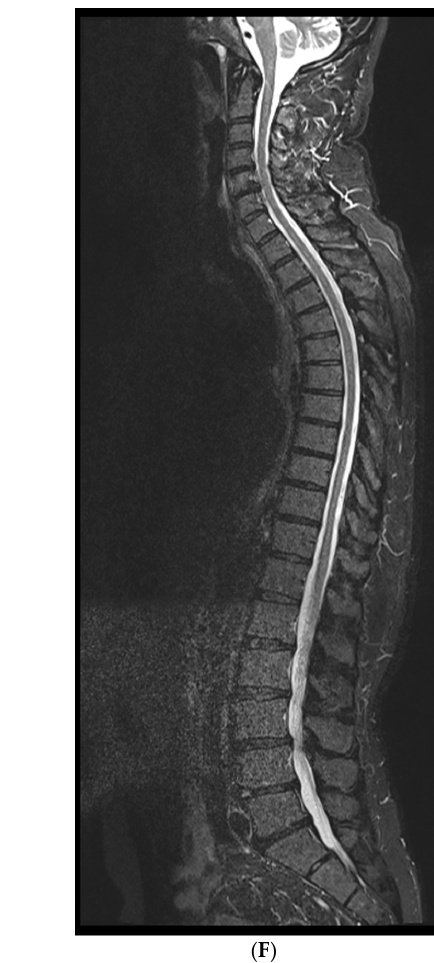
Figure 1. IgGk smoldering multiple myeloma (SMM) patient with negative whole-body computed tomography. Magnetic resonance imaging of the rachis and pelvis shows two focal bone lesions with increased signal intensity in T2-weighted STIR (short-tau inversion recovery) images. One small lesion (diameter: 5 mm) of the right iliac crest ( A ) and one bigger lesion (diameter: 14 mm) of the right acetabulum anterior column ( B ), with corresponding enhancement after Gadolinium injection in T1-weighted images with fat saturation ( C , D ). No further focal lesion of the rachis was detected in whole-rachis sagittal T1-weighted and T2-weighted STIR sequences ( E , F ). These two focal bone lesions are considered a myeloma-defining event leading to the recommendation to treat this